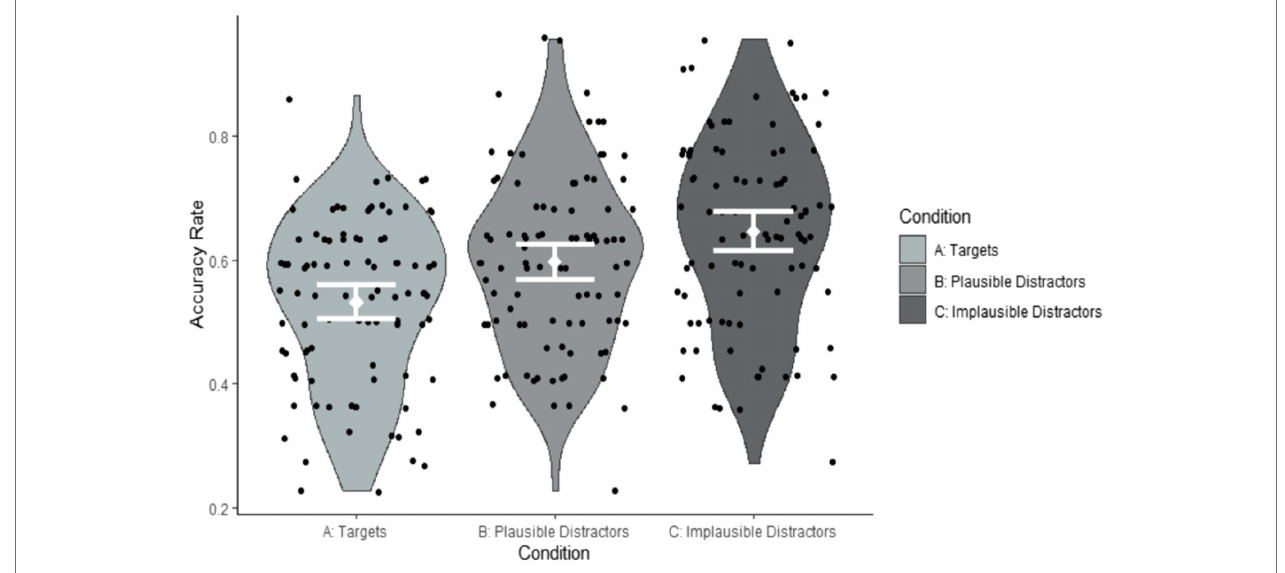
FIGURE 2 | Accuracy rates by condition summarised by participants (Correct response Condition A: Yes; Correct response Conditions B and C: No).